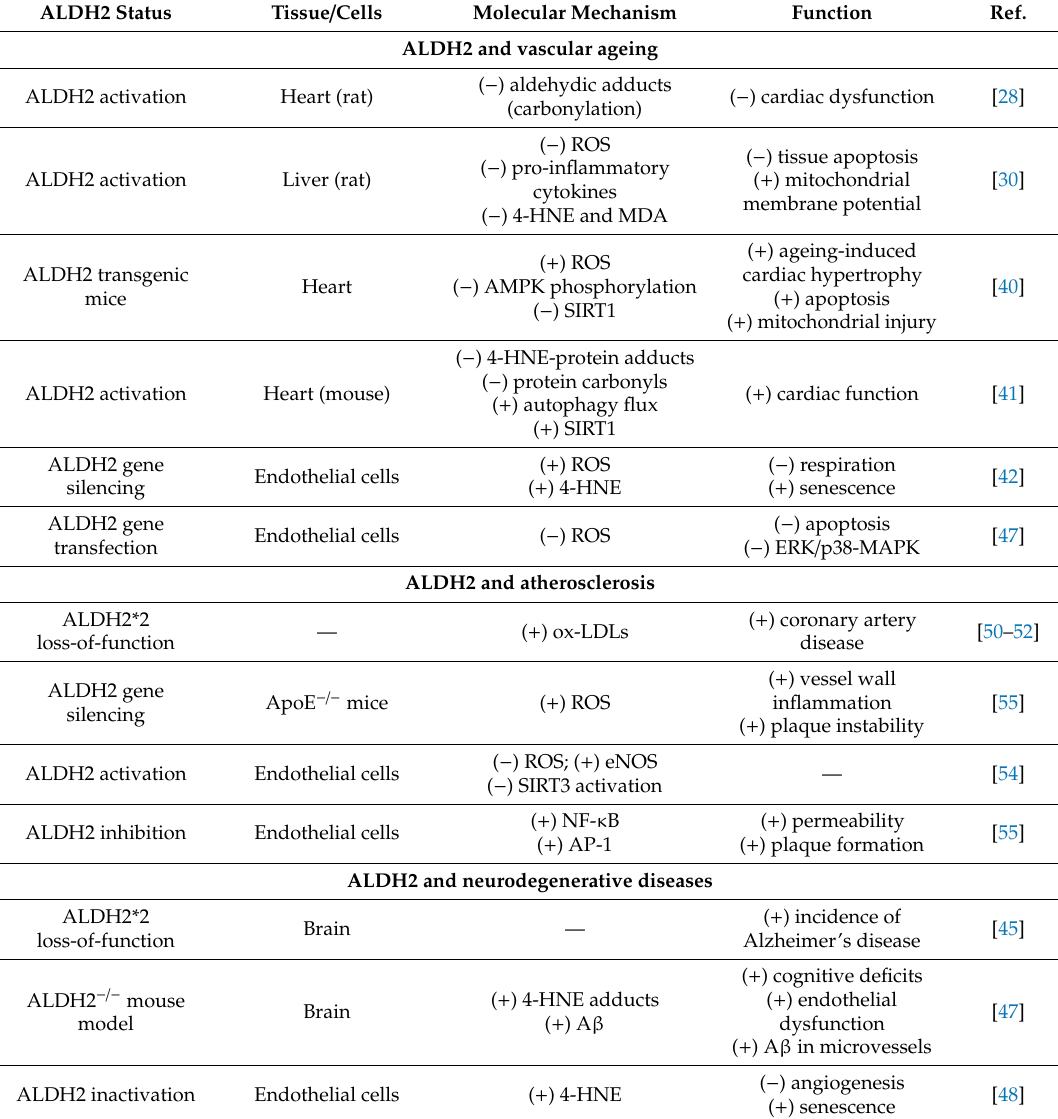
Table 1. Summary of main findings of ALDH2 and ageing, atherosclerosis or neurodegenerative